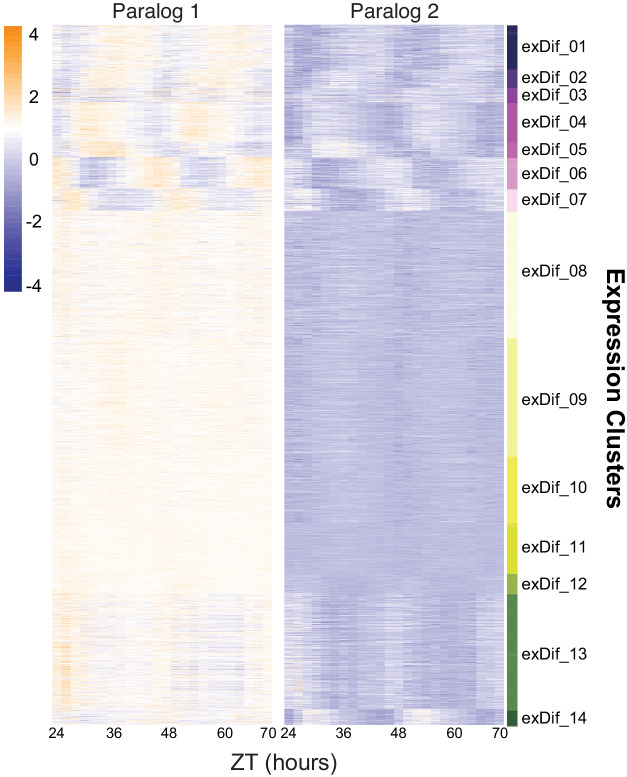
Divergence in median expression levels among retained paralogs.Heatmap of the results from the DiPALM exDif clustering showing the changes in expression pattern for paralogous pairs. Each line of the heatmap for each block corresponds to a paralogous pair. Three copy paralogs were split into three, two-way comparisons. Expression values are log2 transformed FPKM values and the expression is arranged by ZT time across the x-axis. Higher expression levels are in orange and low expression levels are in purple.